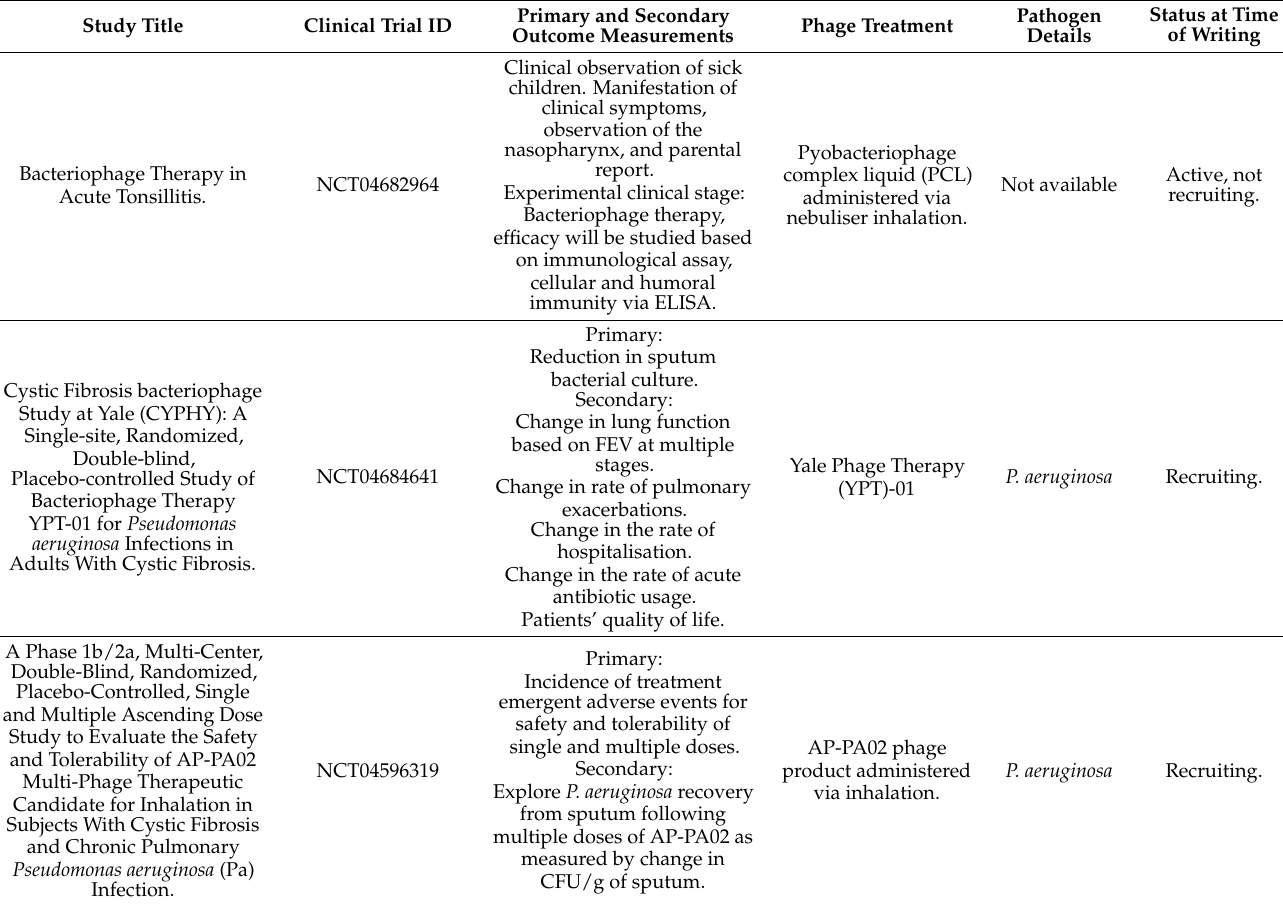
Table 2. Clinical trials involving the use of PT for respiratory infections. Clinical trial ID refers to the ClinicalTrials.gov identifier code. Included are only clinical trials that have the term “Bacteriophage” used as a key word and those that are for the treatment of respiratory